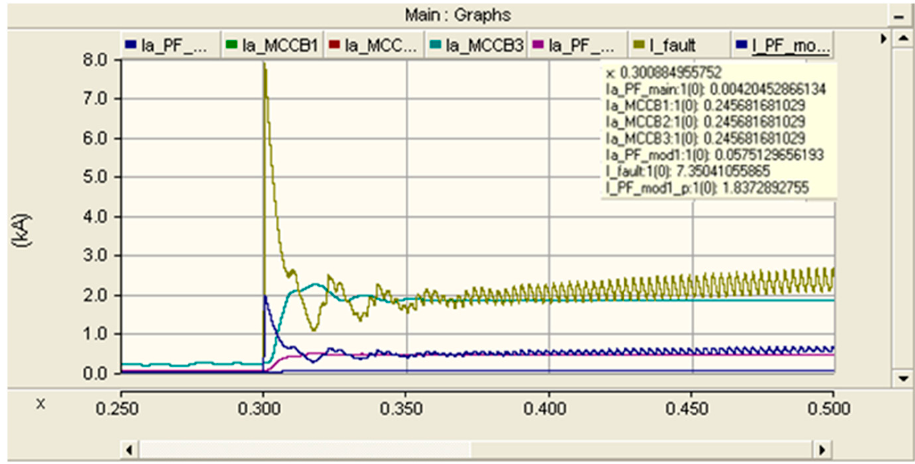
Figure 13. Fault current passing through protection devices during DC fault.